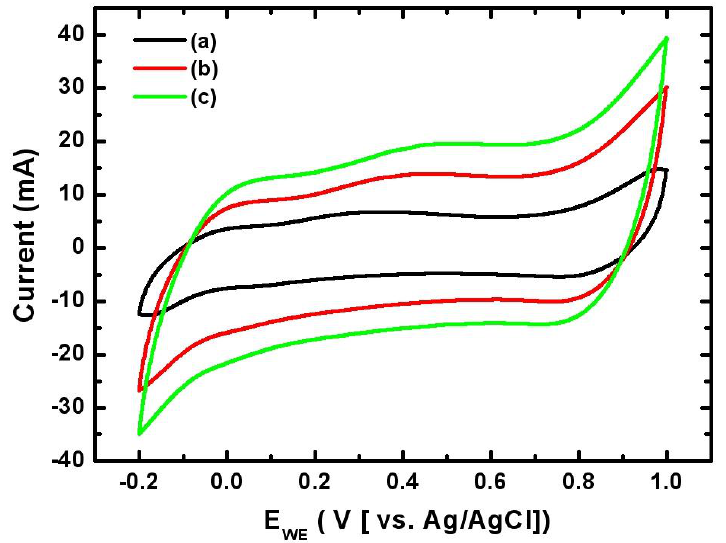
Figure 5. Cyclic voltammograms of the electrodeposited Mn-Ni oxide electrode in 0.5 M Na SO at scan rates of ( a ) 20; ( b ) 60; and ( c ) 100 mV/s. 2 4